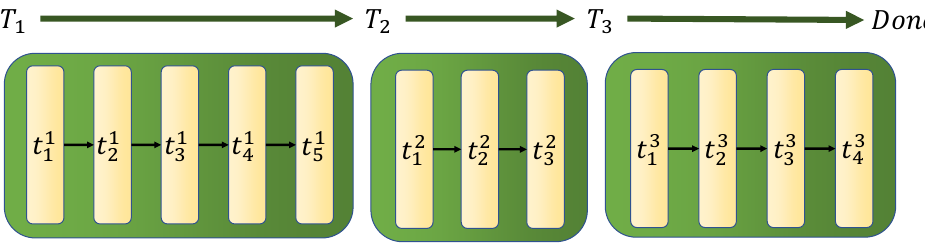
Figure 1. Time steps of an example episode. The time step of the allocation environment is denoted by T i and the time step of the inner environment is denoted by t i algorithm has allocated robots 3 times and makespan is 12 = ( 5 + 3 + 4 ) .